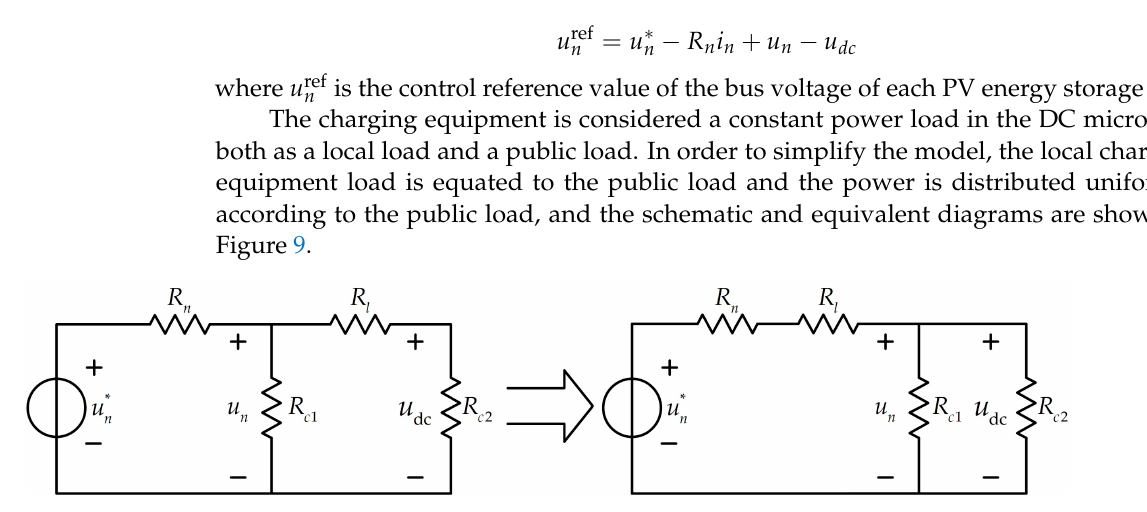
Figure 9. Equivalent schematic of microgrid for equating local charging load to public load.